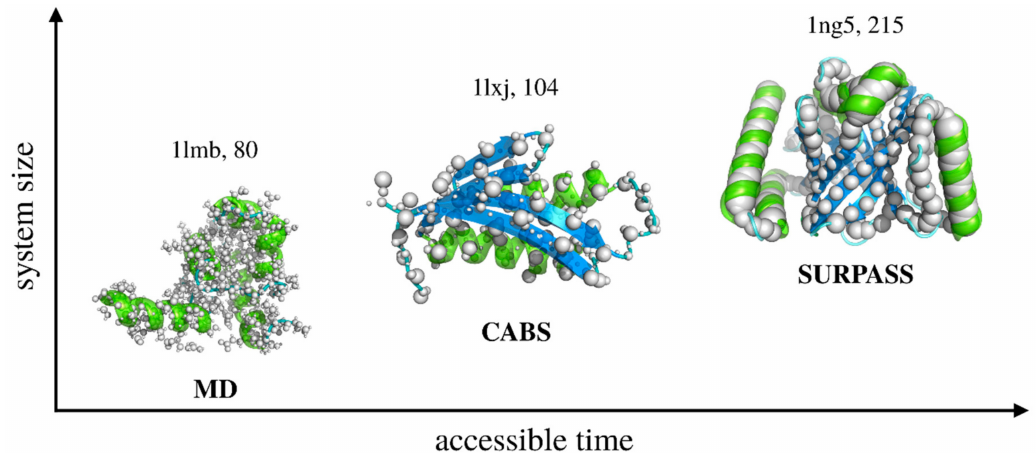
Figure 2. Increasing range of applicability of dynamics modeling, from MD to deeply coarse-grained simulations. CABS (assuming C-Alpha, C-Beta, and side-chain representation of polypeptide chains) is a moderate resolution model of protein structure and dynamics. SURPASS is a deeply CG model, where single united residues represent entire amino acids. Both CG structure models use Monte Carlo dynamics sampling for fast simulations of long-time protein